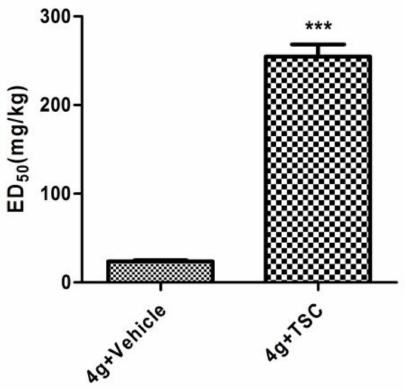
Figure 4. Effect of the thiosemicarbazide (TSC) on the anticonvulsive action of 4g against maximal electroshock-induced seizures in mice. All data are presented as median effective dose (ED 50 ) ± SEM. All drugs were administered i.p. in a single injection, 30 min before maximal electroshock-induced seizures; *** p < 0.001 vs. control group (pretreatment with